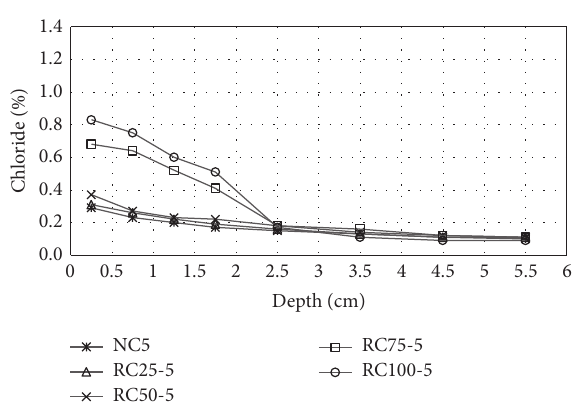
Figure 9: Chloride profiles for 0.5 w/c.